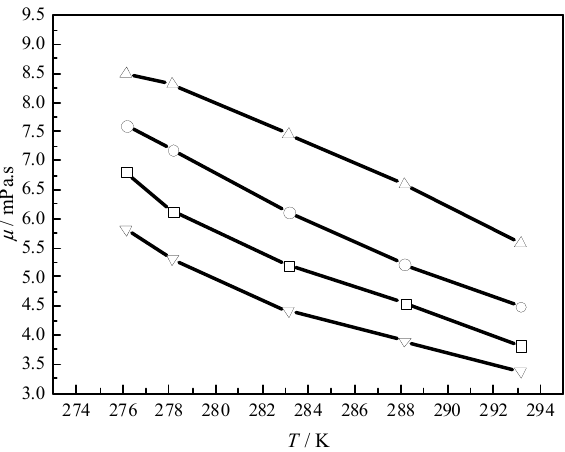
Figure 2. Viscosity of ( ▽ ) diesel oil and water-in-oil emulsion with AA-2 for a water cut of ( □ ) 10 vol %; ( ○ ) 20 vol %; ( △ ) 30 vol %. Lines are provided to guide the eye.